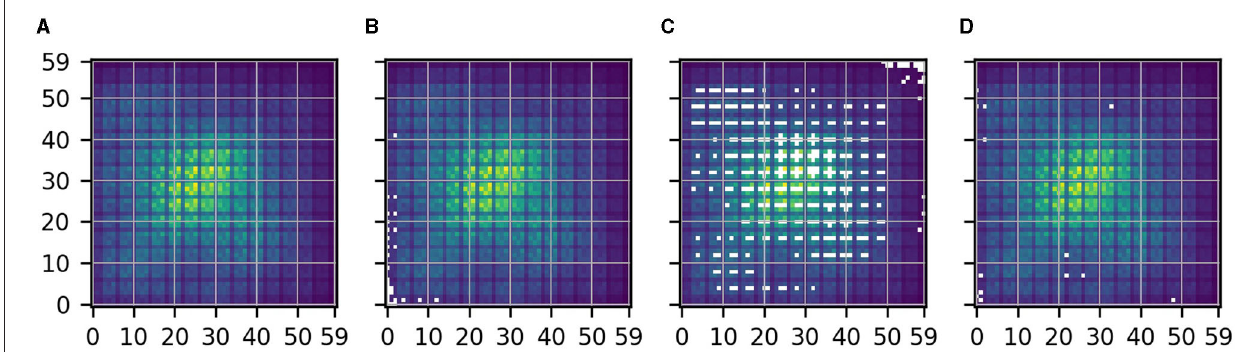
FIGURE 5 | Same as Figure 3 but for CNN2. (A) Original. (B) Sampling. (C) Size. (D) Location.